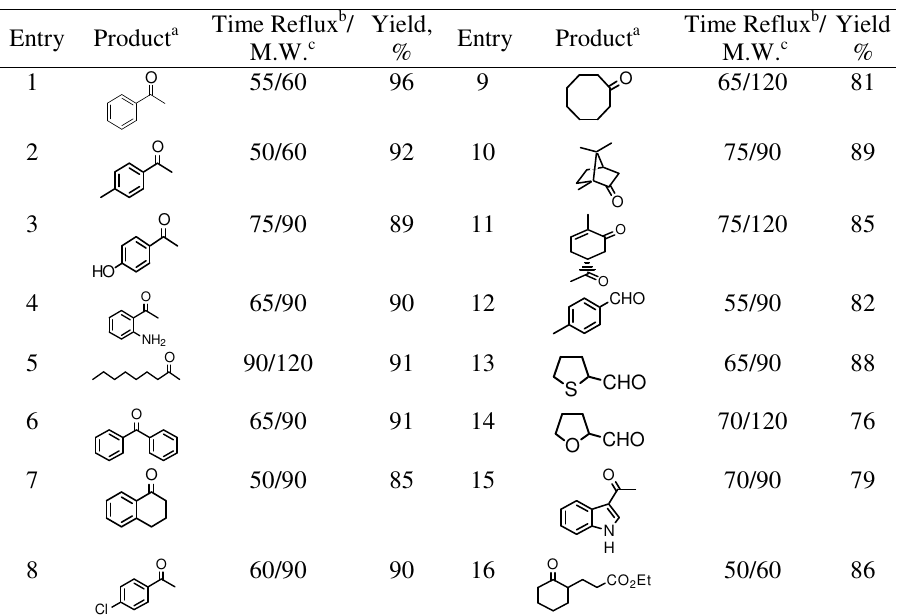
Table 1. Deoximation with N, N -dichloro poly(styrene-co-divinylbenzene)sulphonamide produced via Scheme